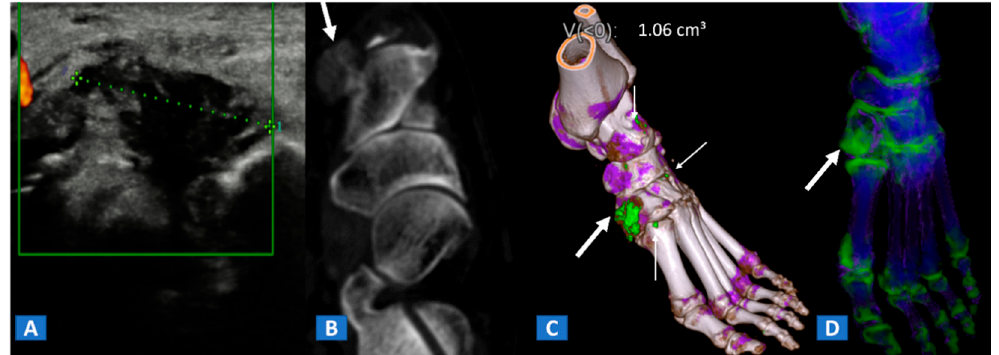
Figure 9. A 48-year-old female with painful gout. Upon ultrasound study, a hypoechoic tophus is identifiable ( A ). In the axial CT image with soft-tissue window ( B ), the tophus shows soft-tissue density (arrow). On the 3D DECT image for gout analysis ( C ), the tophus is coded in green (thick arrow). Note the presence of tiny additional tophi (thin arrows). On the DECT 3D map ( D ), BME can be identified on the intermediate cuneiform and on the base of the first metatarsal bone; this may be an additional factor contributing to pain.